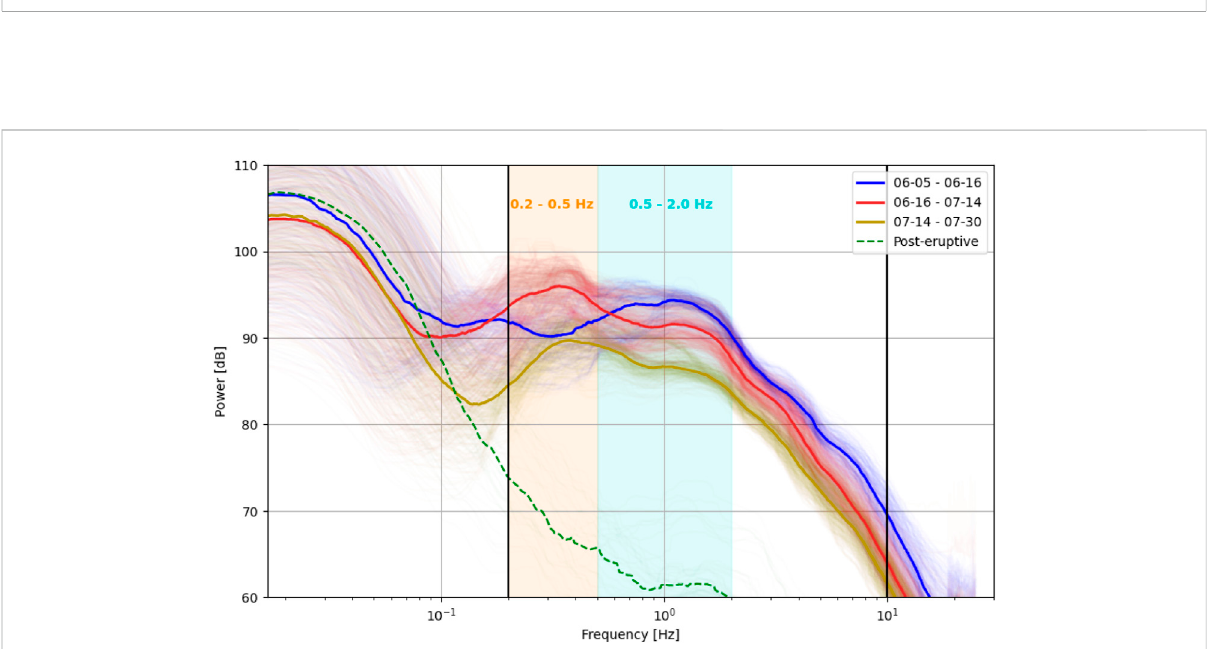
FIGURE 5 Overview of infrasound properties. (A) Shows the beamformed waveform using all four infrasound microphones, (B) the spectrogram and 10 h rolling mean peak frequency in purple and (C) shows the calculated 10 h rolling mean sound pressure level (SPL) for different frequency bands labeled in the legend. The background colors are the same as in Figure